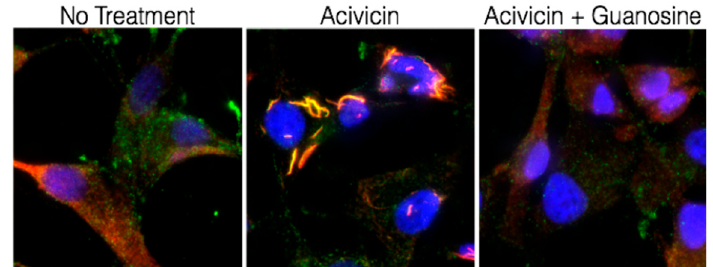
Figure 10. IMPDH Ring and Rod (RR) structure is responsive to GTP concentration. A total of 100 μ M Acivicin (GMP synthase inhibitor) treatment for 6 hours decreased cellular GTP levels (data not shown) and induced RR structure formation in U87MG cells, which was rescued by 2 hours pre-treatment with 100 µ M guanosine that increased cellular GTP (data not shown).